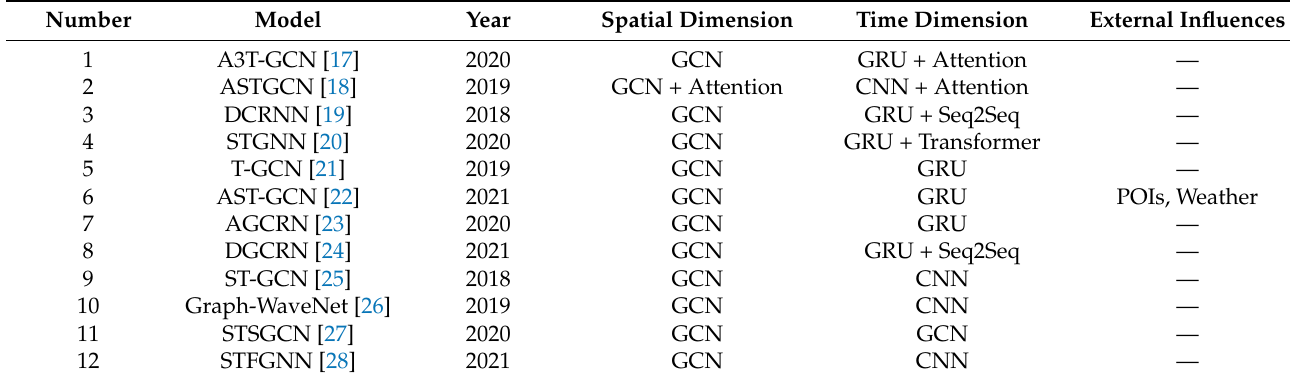
Table 2. Summary of spatiotemporal prediction modeling